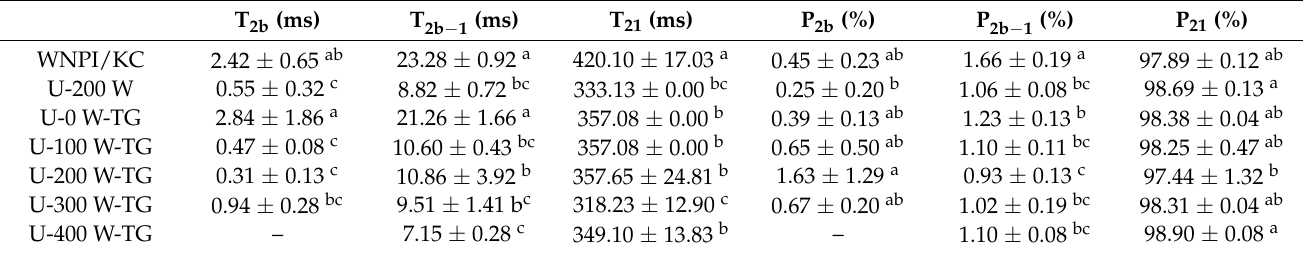
Table 1. Effects of ultrasonic power on transverse relaxation time and peak area of WNPI-KC composite gels. Different letters in the same column indicate significant differences ( p <